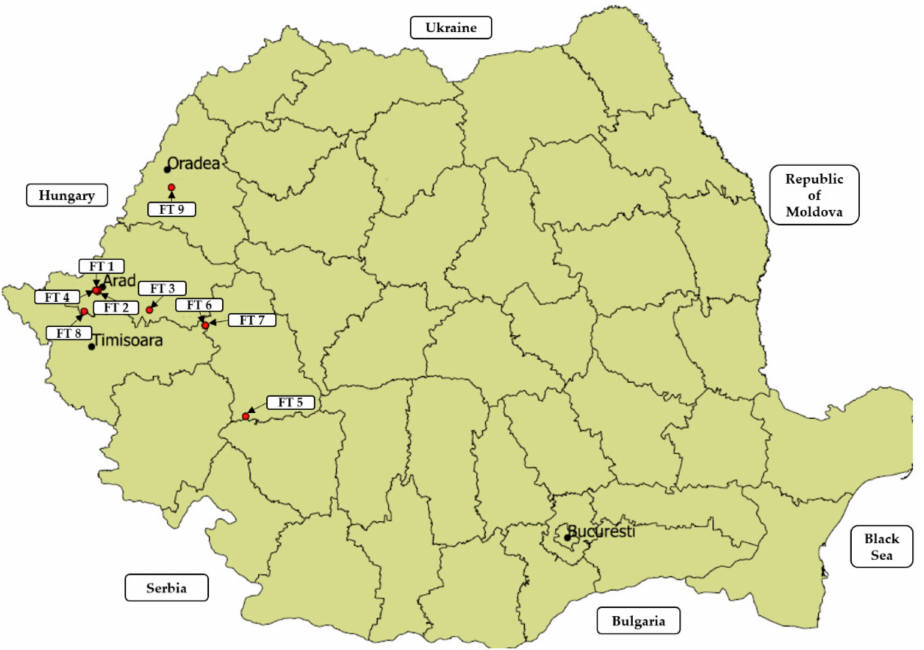
Figure 1. Map of Romania showing the locations of field tests. Legend: FT1–FT9 stand for the field tests 1 to 9. Two drill sizes were experimented on each site, using a 1.3 kW, 9.4 kg Stihl BT 121 (Figure 2) auger (Stihl, Waiblingen, Germany). In the first treatment, a drill that was 150 mm in diameter (hereafter D 150 ) was used to make cylindrical pits with a depth of 300 mm, while in the second treatment a drill that was 200 mm in diameter (hereafter D 200 ) was used to drill at the same